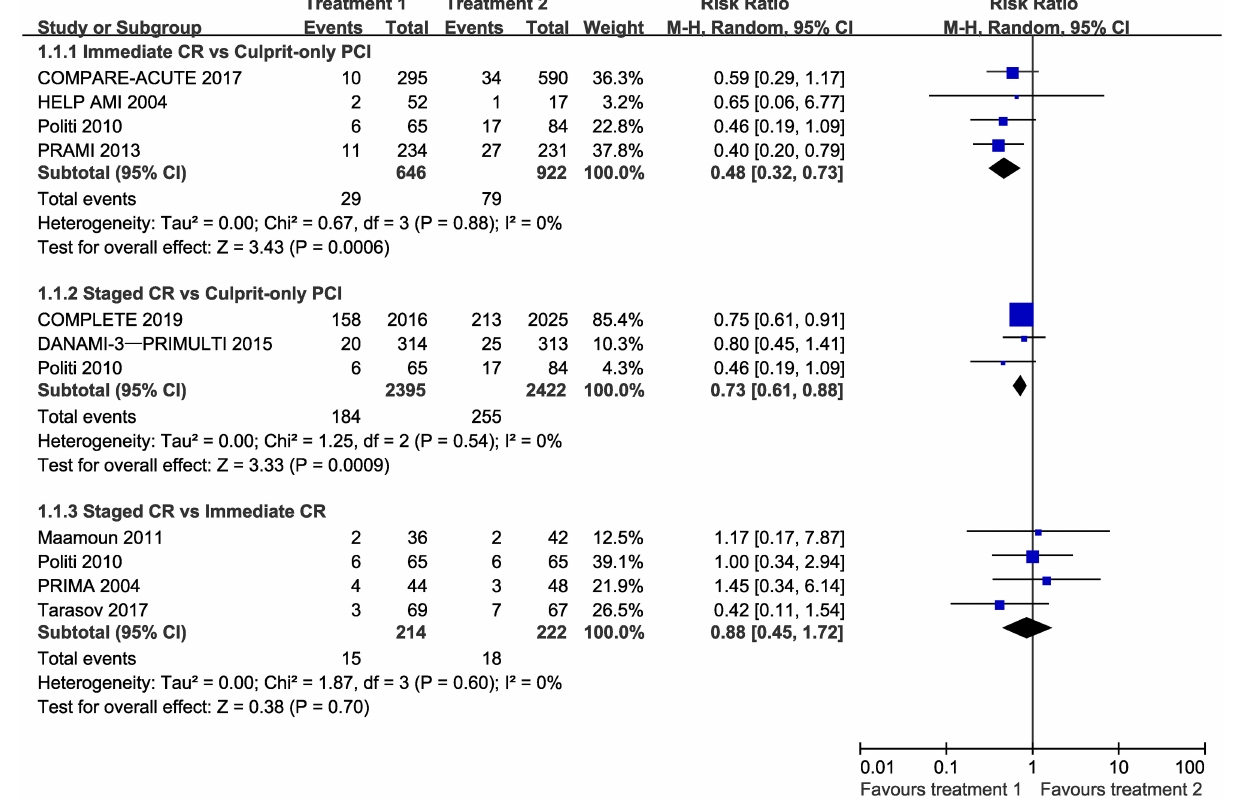
Frontiers in Cardiovascular Medicine |